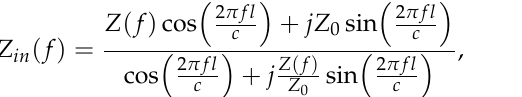
Figure 15. The current, voltage and power for the case of transmission line and pulse train current.